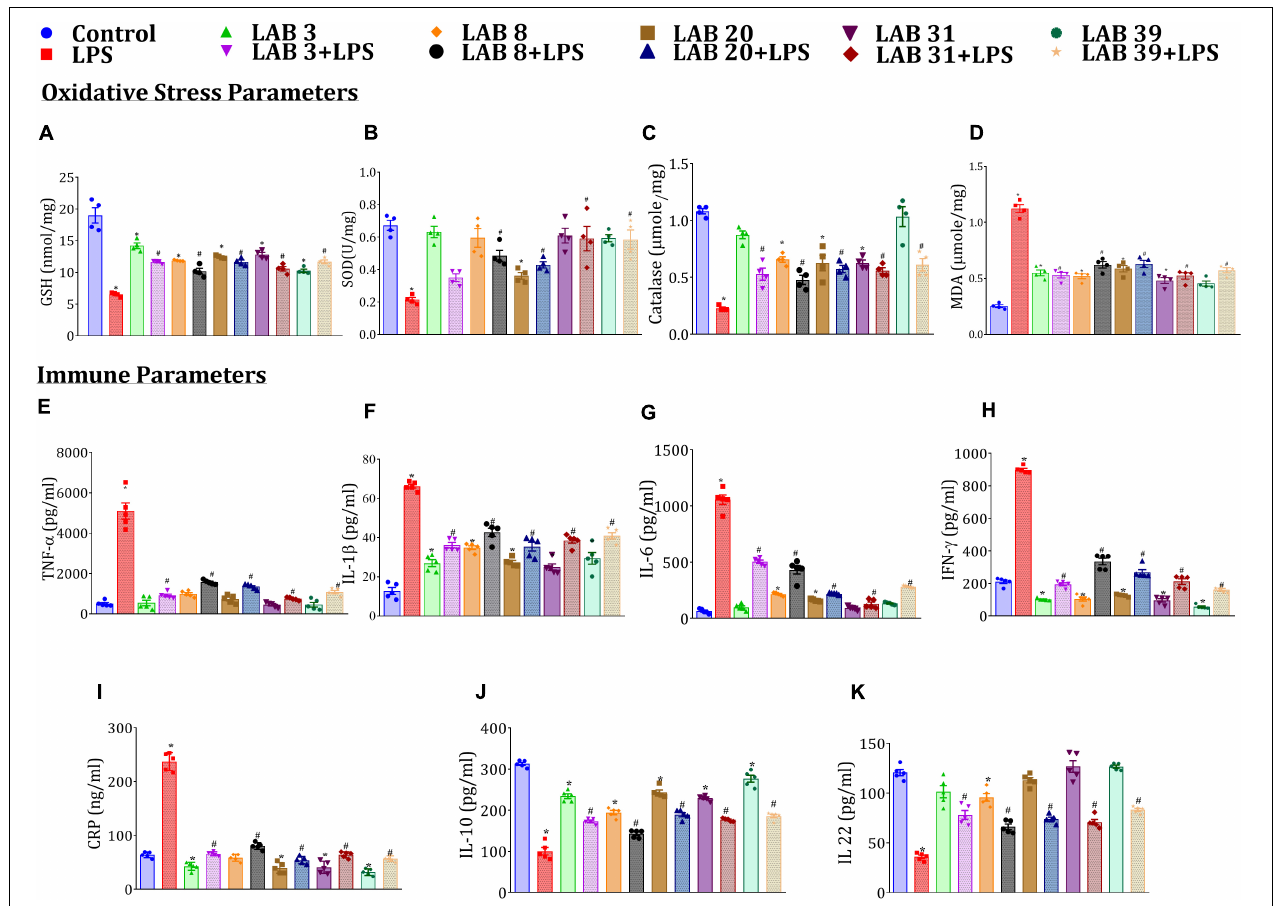
FIGURE 3 | Effect of LAB supplementation on the oxidative stress and systemic inflammation caused by LPS: (A) GSH; (B) SOD; (C) catalase; (D) MDA; (E) TNF- α ; (F) IL-1 β ; (G) IL-6; (H) IFN- γ ; (I) CRP; (J) IL-10; and (K) IL-22. Data were analyzed by one-way ANOVA with Tukey’s post hoc test ( P ≤ 0.05). *Significant relative to control; # significant relative to LPS-treated animals ( N = 4 for oxidative stress parameters; N = 5 for immune